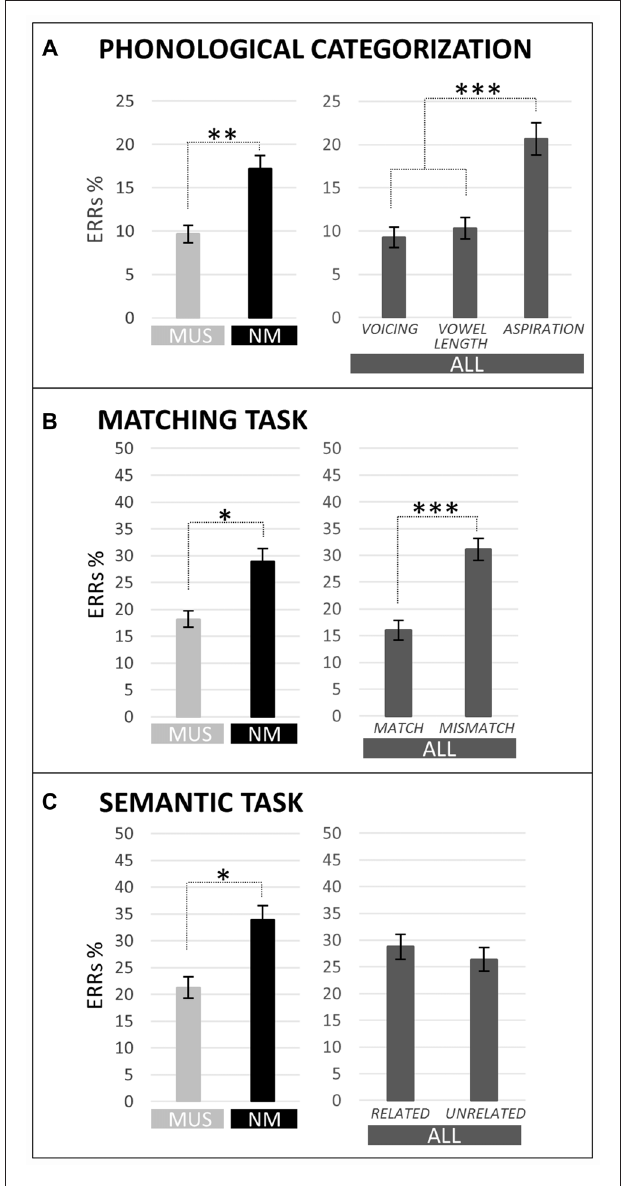
FIGURE 2 | Percentages of error (ERRs) are compared for children with music training (MUS) in light gray and for children without music training (NM) in black in the different tasks (main effect of group). Moreover, ERRs in the different tasks are also shown averaged across children (ALL; main effect of condition) in dark gray. For the phonological categorization tasks (A) , results are illustrated for voicing, vowel length and aspiration. For the matching task (B) , results are illustrated for Match and Mismatch words. For the semantic task (C) , results are illustrated for semantically Related and Unrelated words. Level of significance is indicated by stars with ∗ p < 0.05, ∗∗ p < 0.01 and ∗∗∗ p <